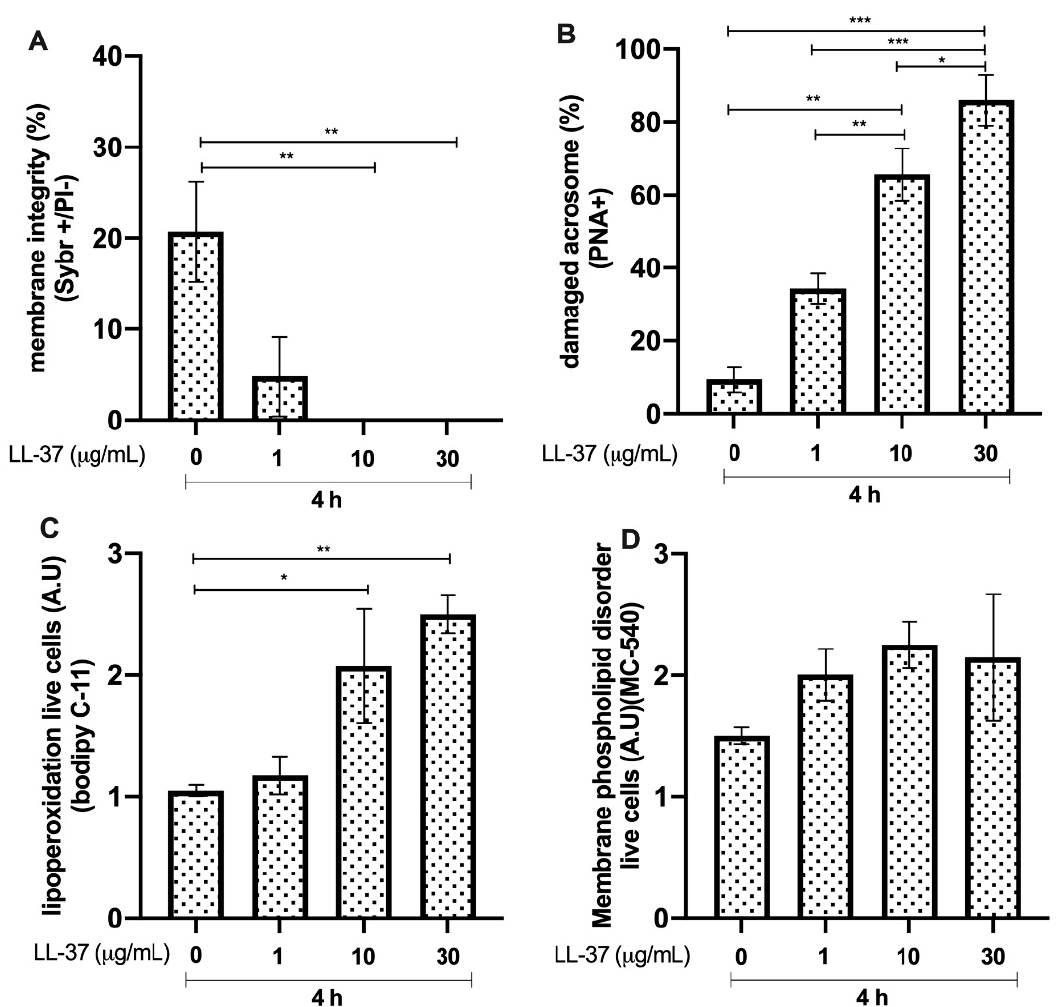
Figure 6. Effect of different concentrations of cathelicidin LL37 (LL-37) on bull sperm. ( A ) Plasma membrane integrity. ( B ) Damaged acrosomes. ( C ) Lipid peroxidation. ( D ) Membrane phospholipid disorder. The results are shown as the mean ± standard deviation. The asterisks (*, **, ***) above the bars indicate differences between the groups ( p < 0.05, p < 0.01, and p < 0.0001) based on three bio- logical replicates.